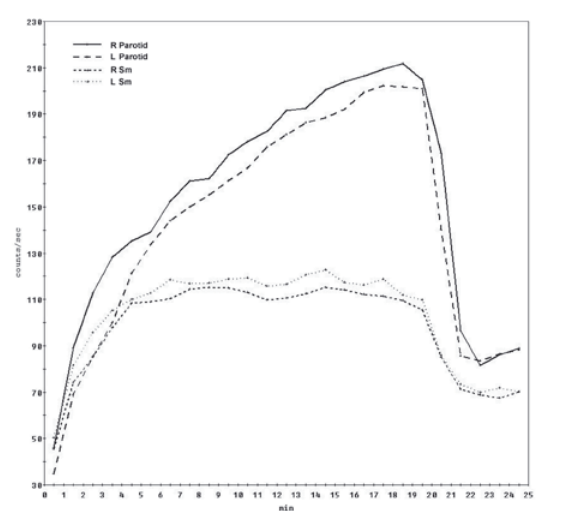
Figure 2. Regions of interest on a scintigraphic image. RP, right parotid; LP, left parotid; RSm, right submandibular gland; LSm, left submandibular gland; B, background.